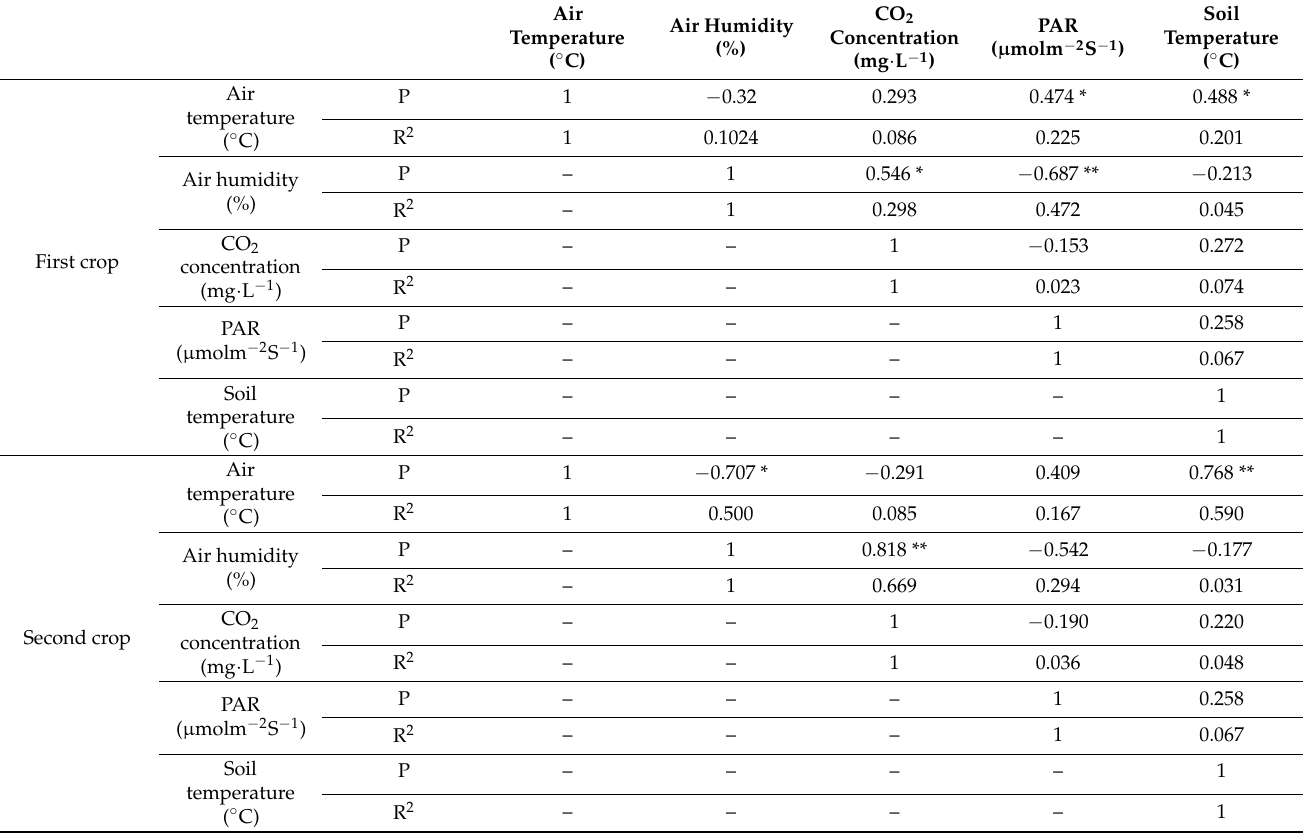
Table 10. Analysis of correlation coefficient of greenhouse environment under light conversion